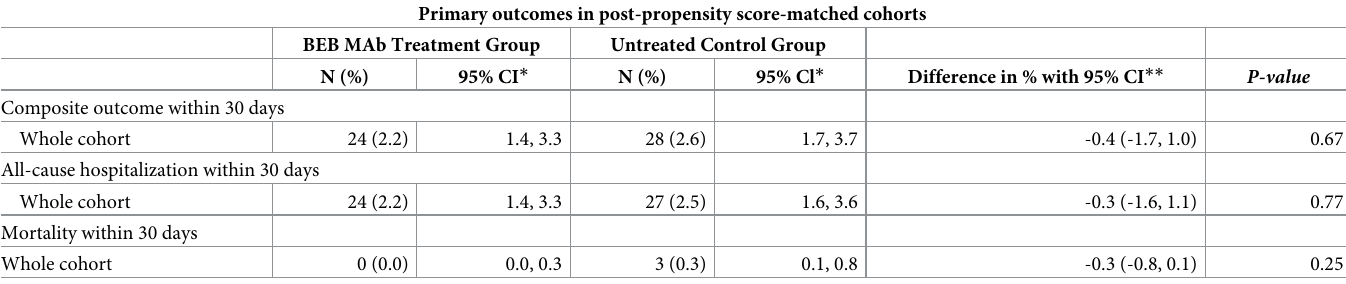
Table 2. The primary composite outcome between the propensity matched Bebtelovimab (BEB) monoclonal antibody (MAb) and untreated control groups. Primary outcomes in post-propensity score-matched